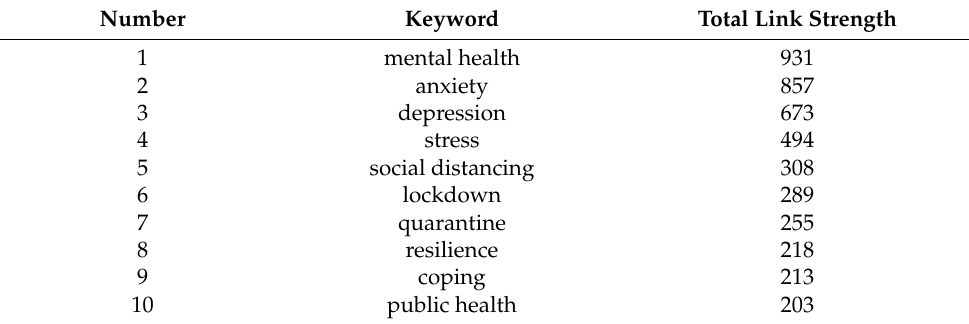
Table 2. Selected top 10 total link strength